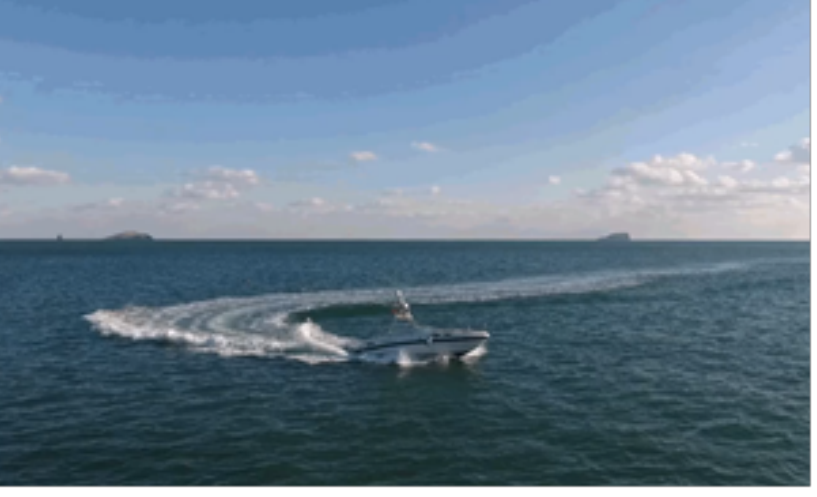
Figure 1. The Lanxin USV at